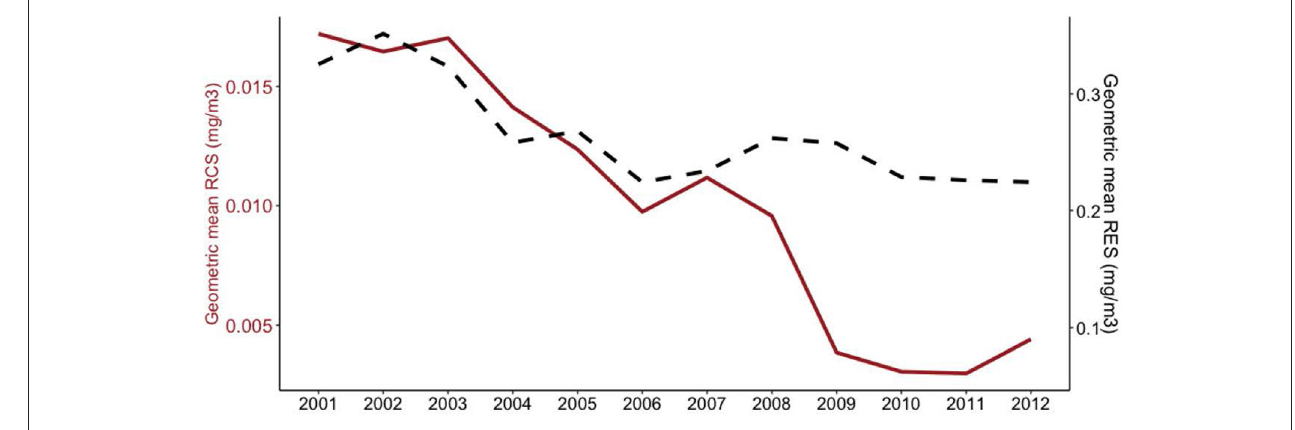
FIGURE 1 | Time trend of GM of RCS and RES concentrations.